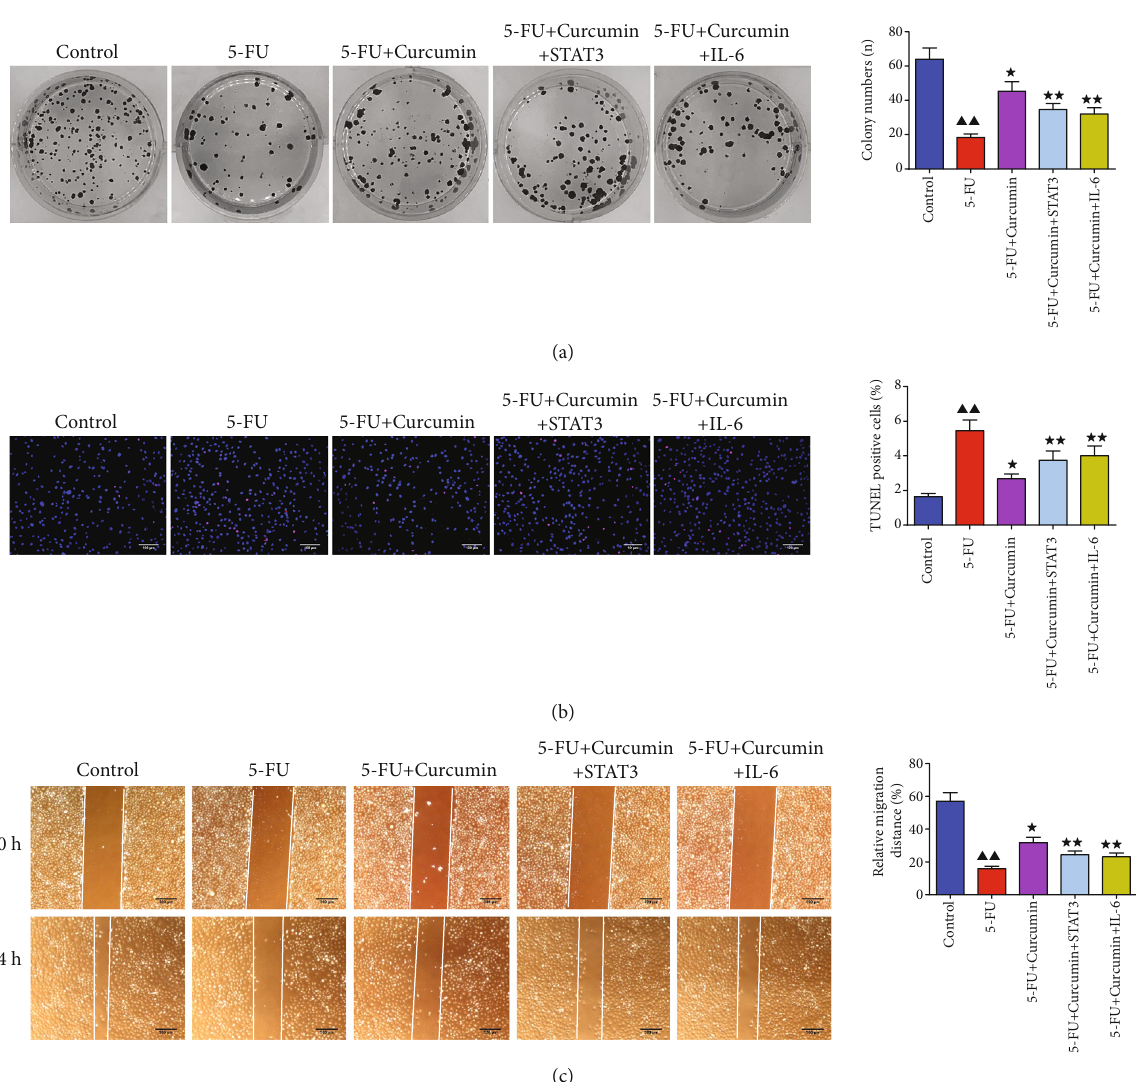
Figure 9: Overexpression of IL-6 and STAT3 reserved the e ff ect of curcumin on 5-FU-stimulated IEC-6 cells. (a) Colony formation assay. (b) TUNEL staining. (c) Wound healing assay. Data were expressed as mean ± standard error mean (SEM), ▲▲ p value < 0.01 vs. control group; ∗ p value < 0.05 vs. 5-FU group; ∗∗ p value < 0.01 vs. 5-FU group. 5-FU: 5- fl